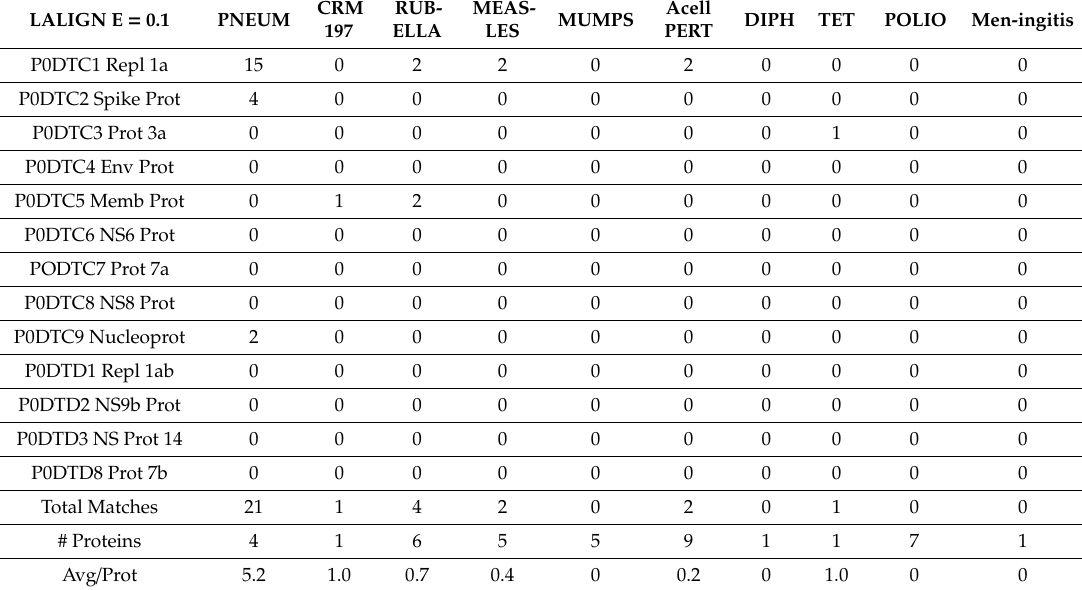
Table 2. Summary of LALIGN searches set to E = 0.1 comparing SARS-CoV-2 proteins (left-hand column) with vaccine proteins (see Table 1 for list of individual proteins). PNEUM = pneumococcal; CRM197 = Cross-Reactive Material 197; Acell PERT = acellular pertussis vaccine; DIPH = diphtheria vaccine; TET = tetanus vaccine; Whole PERT = whole cell pertussis vaccine; BCG = Bacillus Calmette–Guerin, here represented by M. tuberculosis . Avg / Pro = average number of matches per